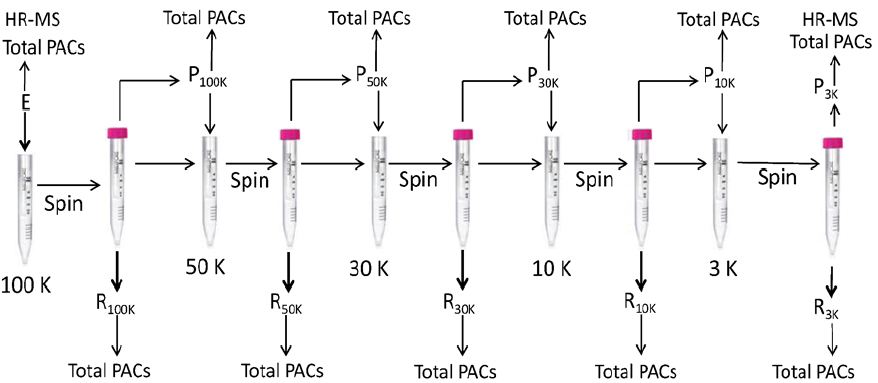
Figure 3. Fractionation of the proanthocyanidins (PACs) by centrifugal filter devices. The extract solution was centrifuged at 4000 × g by a centrifugal filter device containing an ultracel-PL PLHK 100 kDa regenerated cellulose membrane, which allowed the ultrafiltration into the lower chamber (permeate) of substances with MW < 100 kDa. Substances with MW > 100 kDa were collected in the upper chamber (retained). Permeate was then loaded on a 50 kDa filter and centrifuged at 4000 × g until the solution passed completely through the filter. The procedure was repeated on 30, 10, and 3 kDa filters. Permeates and retained fractions were analyzed by the DMAC assay, and the permeates less than 3 kDa were analyzed by UHPLC-DAD-HR MS.